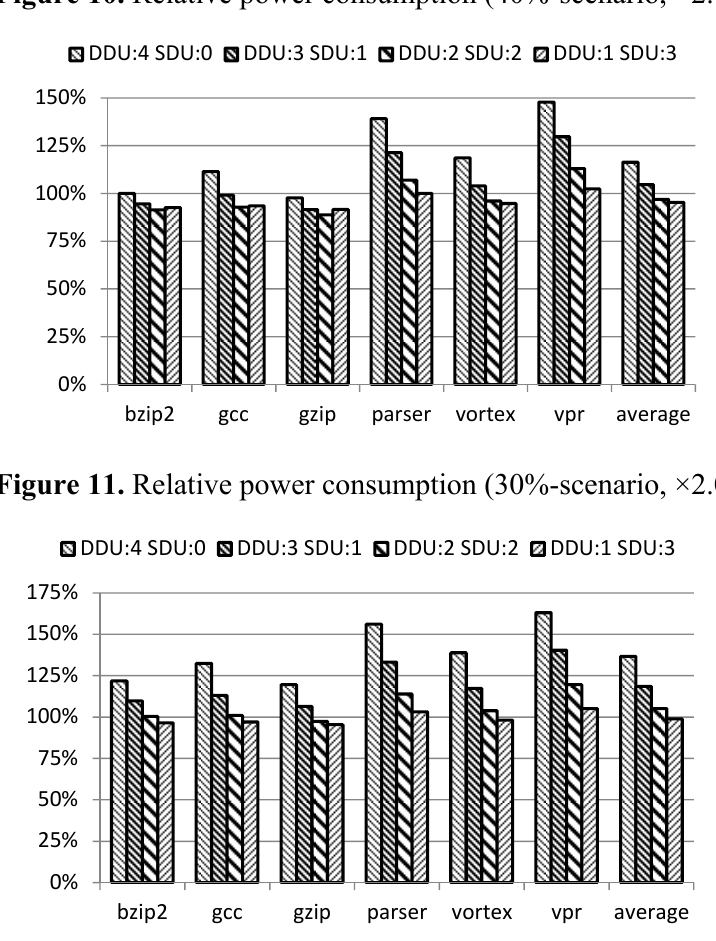
Figure 10. Relative power consumption (40%-scenario, ×2.0).